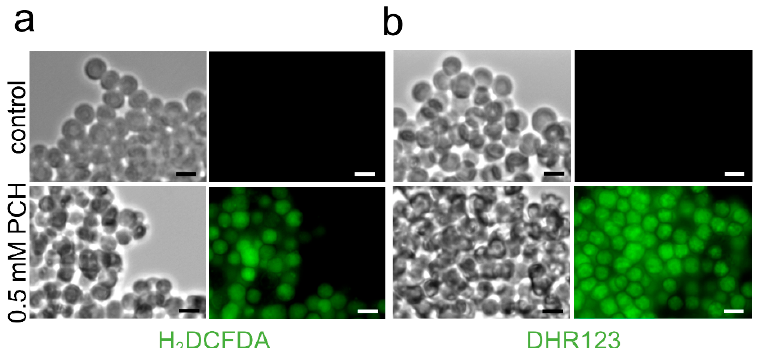
Figure 6. Pyochelin (PCH) induces the production of reactive oxidant (ROS) ( a ) and reactive nitrogen (RNS) ( b ) in swollen conidia using 2 ′ ,7 ′ -dichlorodihydrofluorescein diacetate (H 2 DCFDA) and dihydrorhodamine 123 (DHR123), which are ROS- and RNS-specific fluorescent probes, respectively. Scale bar represents 5 mm. Methodology is described in Supplementary Materials.